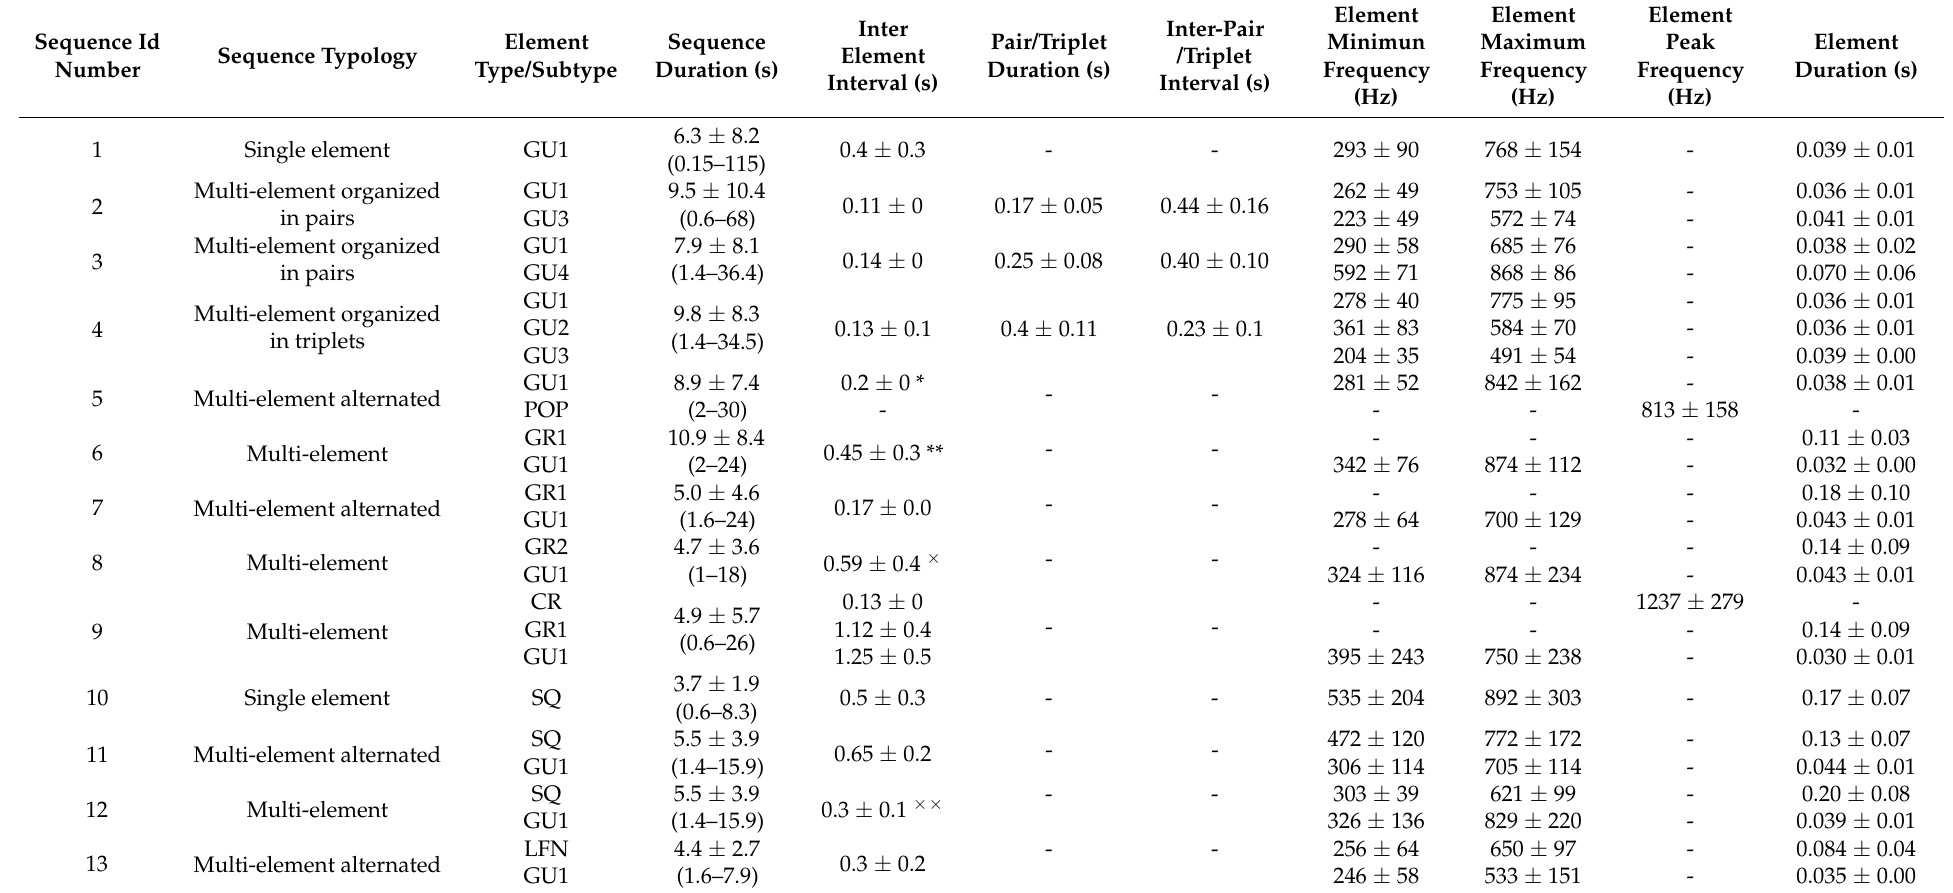
Table 4. Average values of the acoustic parameters of the 13 bray-call sequences, and of the element types and variants measured in each